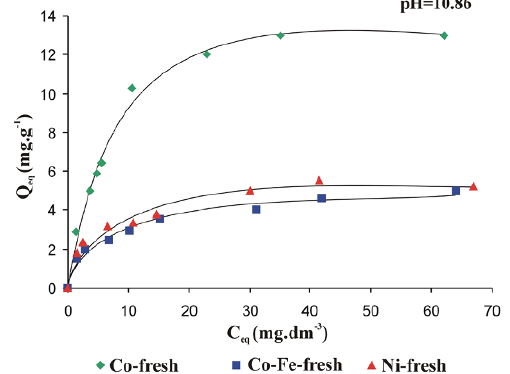
Figure 2. Isotherms of methylene blue adsorption onto catalysts under study at pH